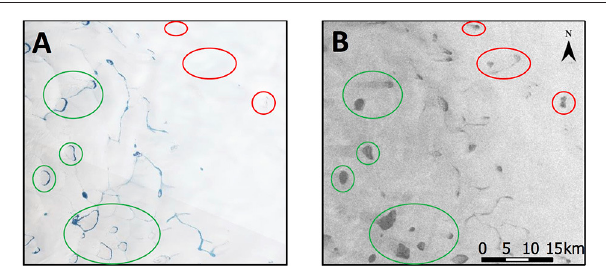
FIGURE 4 | Example of surface lakes partially obscured by snow (location shown in Figure 1 ) in the Landsat RGB false color image on day 235 (2015) (A) , but still detected as liquid water in the Sentinel-1 image (HV polarization) on day 232 (2015) (B) .